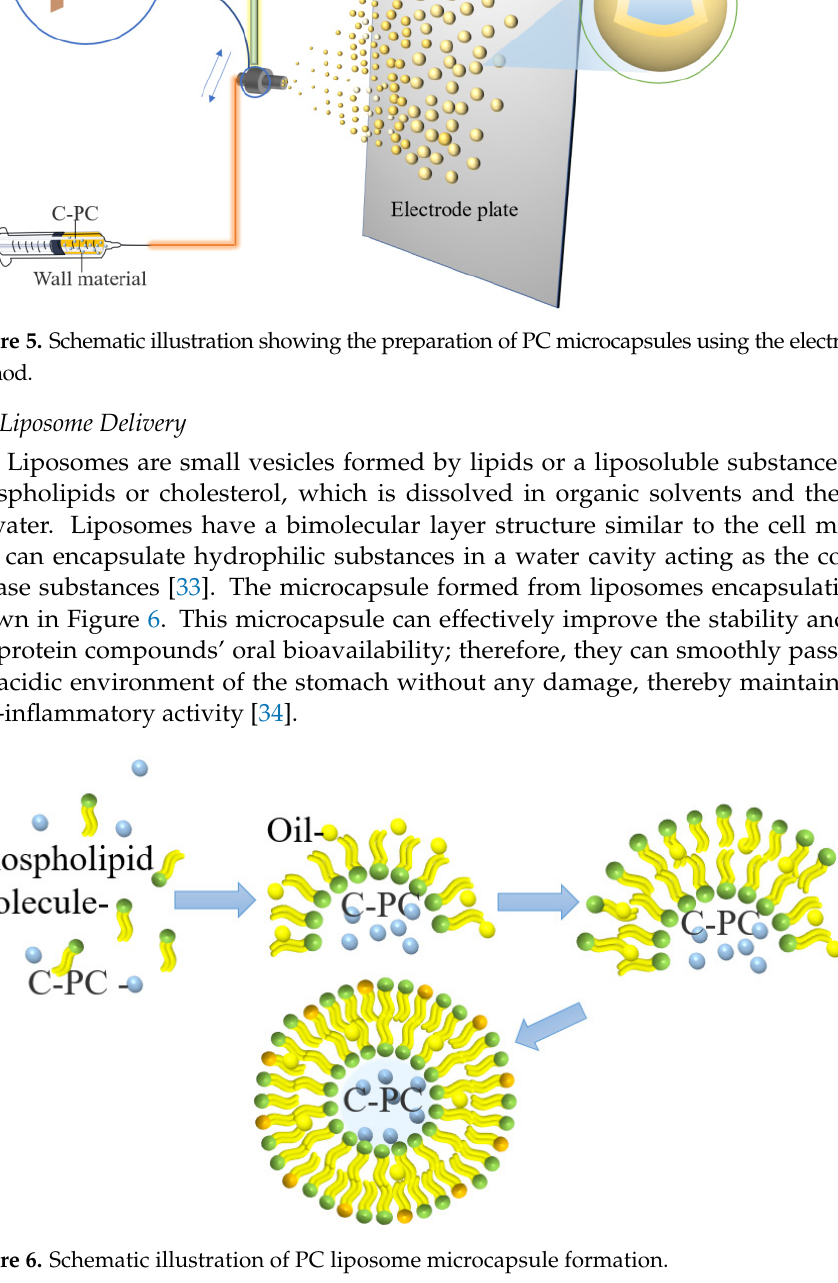
Figure 6. Schematic illustration of PC liposome microcapsule formation.